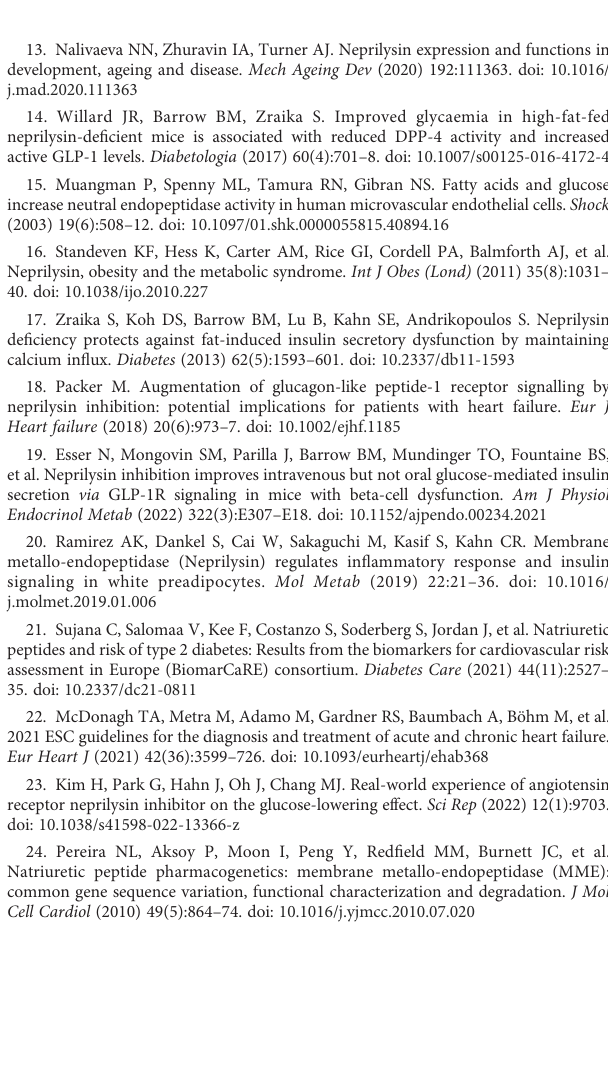
SUPPLEMENTARY DATA SHEET eMethods: A detailed description of the methods of participants selection and data